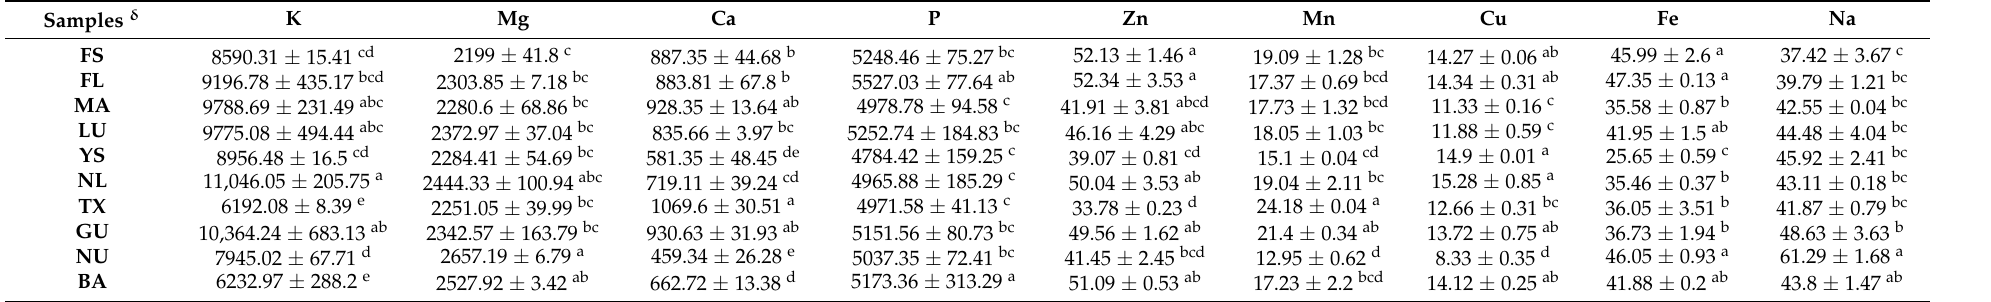
Table 3. Major mineral profile of almond samples (mg/kg).